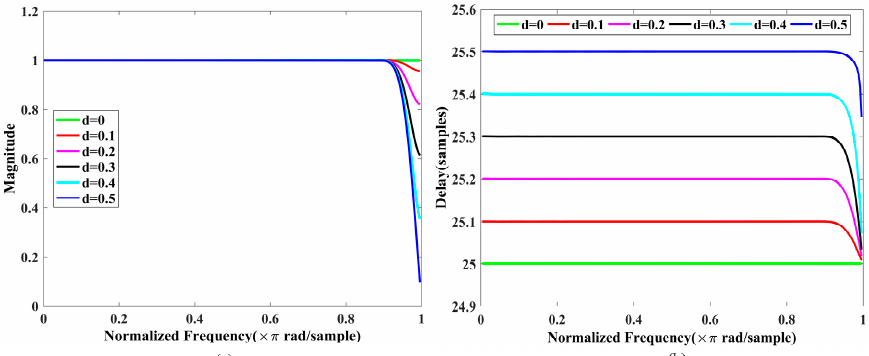
Figure 9. Frequency response of the FD filter: ( a ) magnitude-frequency response and ( b ) phase- frequency response.